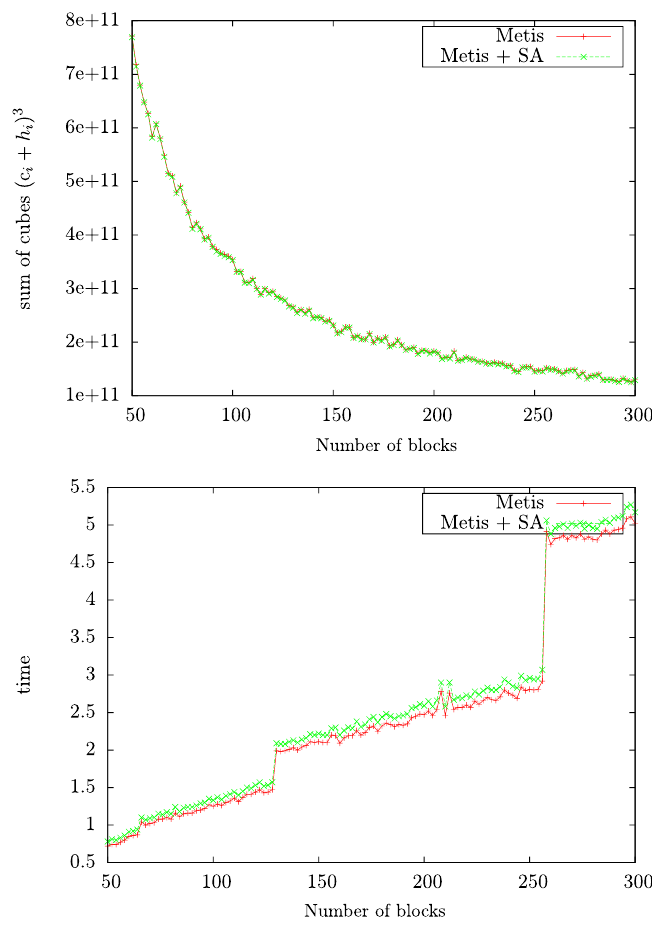
Figure 7. Sum of cubes measure ( top ) and runtime to find the partitions ( bottom ) as a function of the number of blocks. Figure taken from [12]. Copyright c (cid:13) 2016 Society for Industrial and Applied Mathematics. Reprinted with permission. All rights